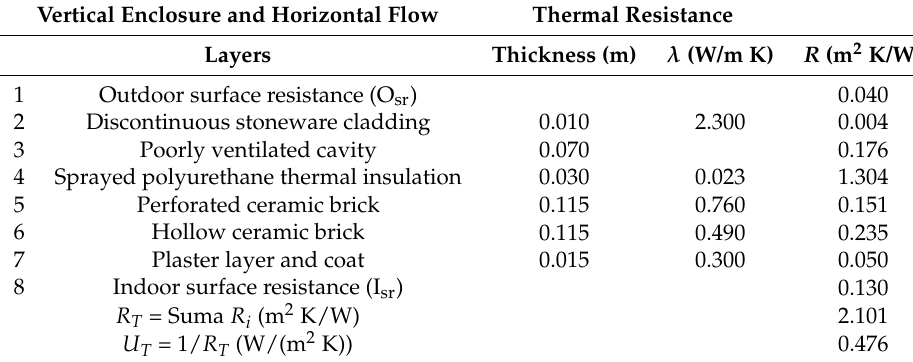
Table 1. U-value according to λ values extracted from the UNE EN ISO 9869-1:2014 standard established by the CTE.